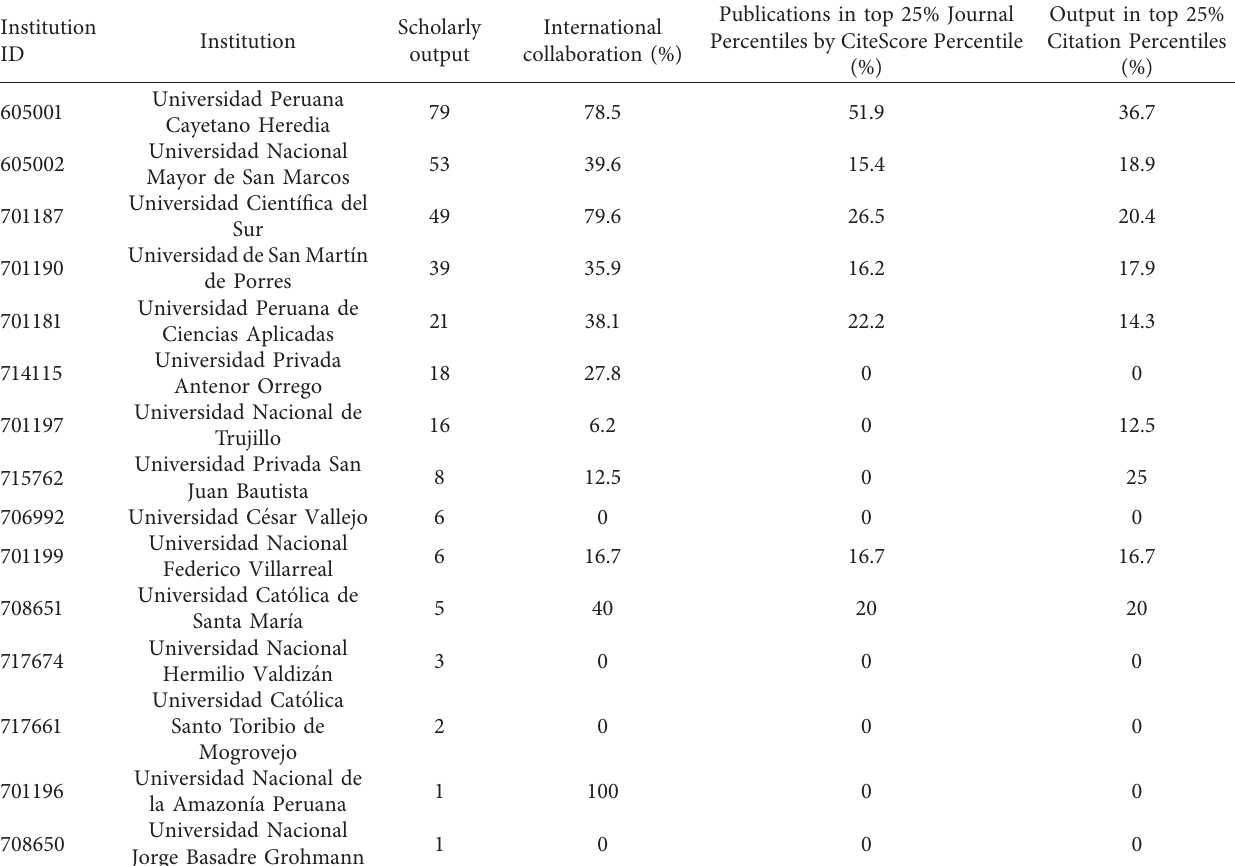
Table 6: Scholarly output and international collaboration (%) according to publications in top 25% Journal Percentiles by